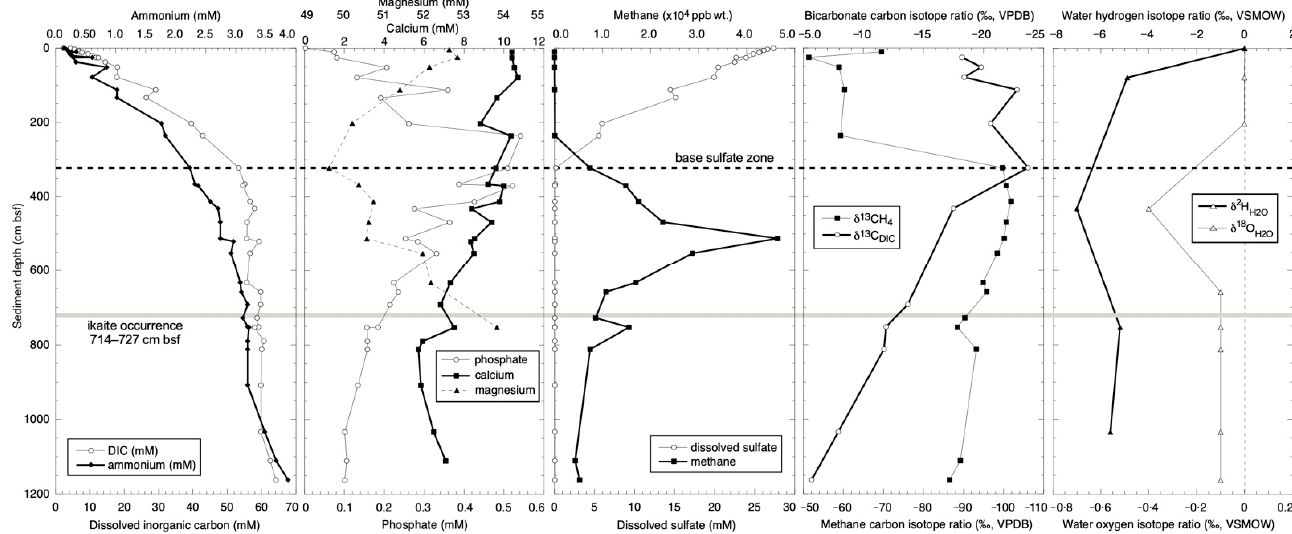
Figure 2. Depth distributions of dissolved nutrients, sulfate, calcium, magnesium, methane, stable carbon, oxygen, and hydrogen isotopes of dissolved inorganic carbon, methane, and interstitial water, as composite from three Bransfield Strait cores ANT 1138-4, 1324-7, and 1327-1. The depth distribution of dissolved DIC is controlled by various and sometimes